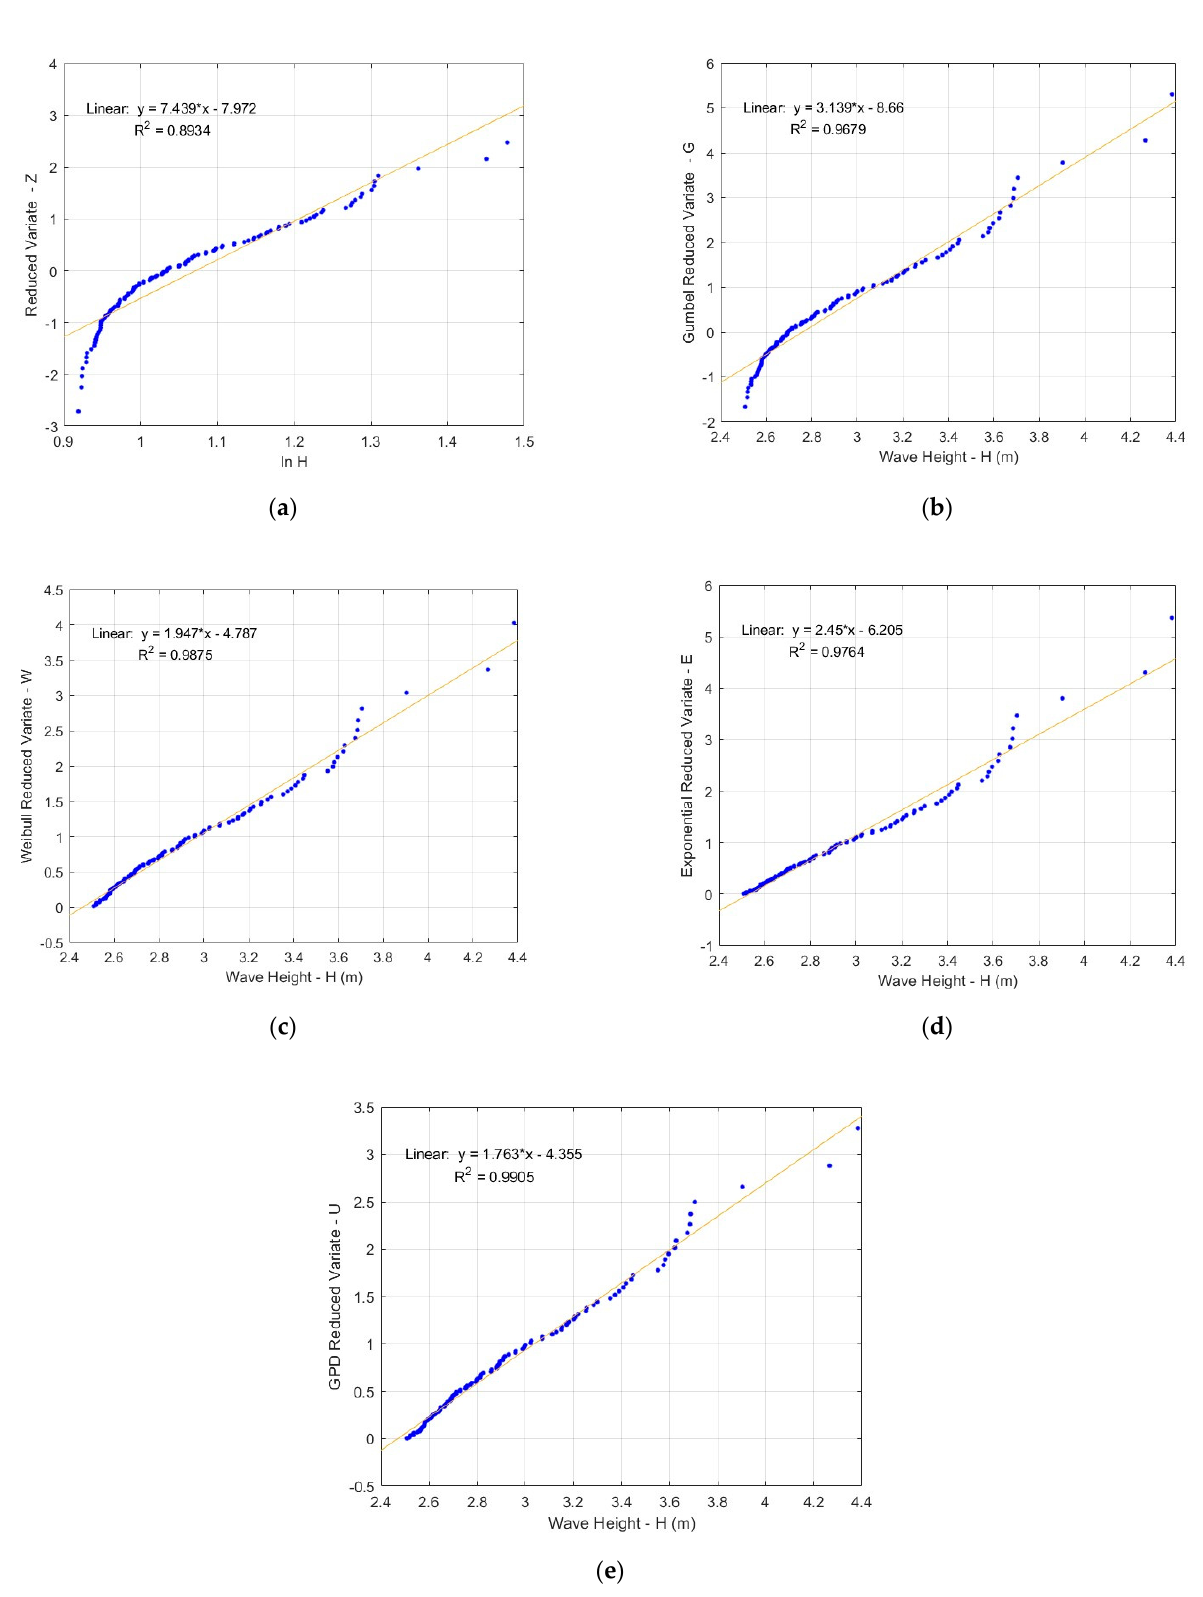
Figure 4. Extreme value distribution plots: ( a ) Log-normal distribution; ( b ) Gumbel distribution; ( c ) Weibull distribution; ( d ) Exponential distribution; ( e ) Generalized Pareto Distribution (GPD). R 2 sum of squares of the error.